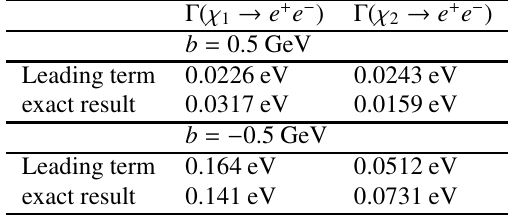
0 . 5 GeV and b = 0 . 5 −